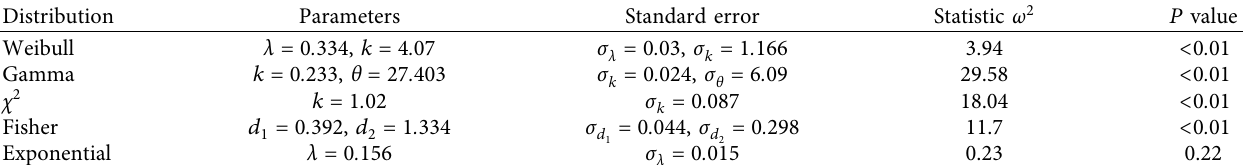
Figure 6: Input data histograms: time intervals between attacks (a) and losses (b). Table 3: Parameter estimates, standard error, and test results of time interval distribution ftting.